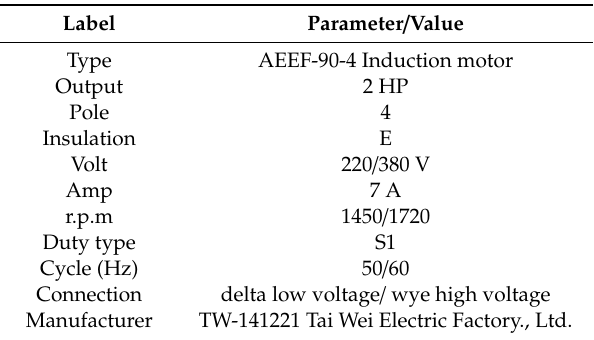
Table 1. Test motor